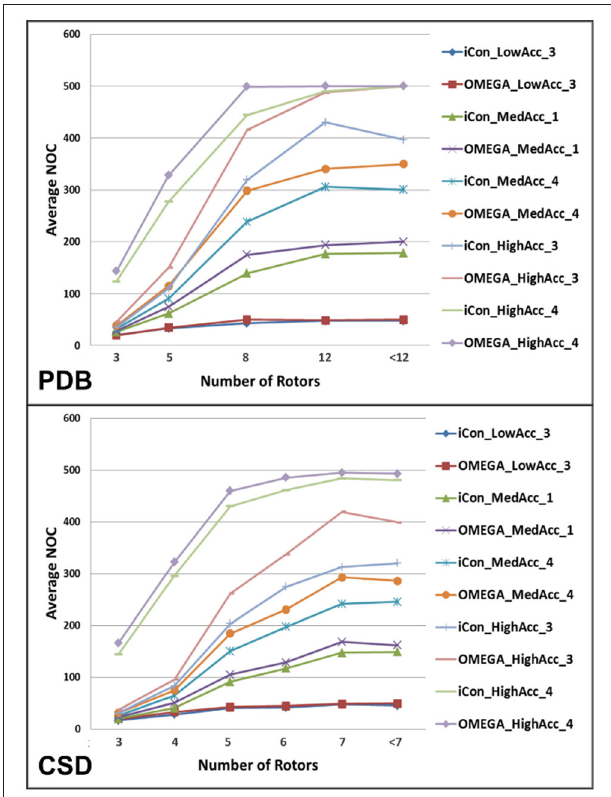
FIGURE 4 | Average NOC generated by iCon and OMEGA, for some representative setting patterns, as a function of the number of rotatable bonds of PDB and CSD compounds. Due to the different rotor distribution in PDB and CSD molecules, different scales have been considered for the two data sets.